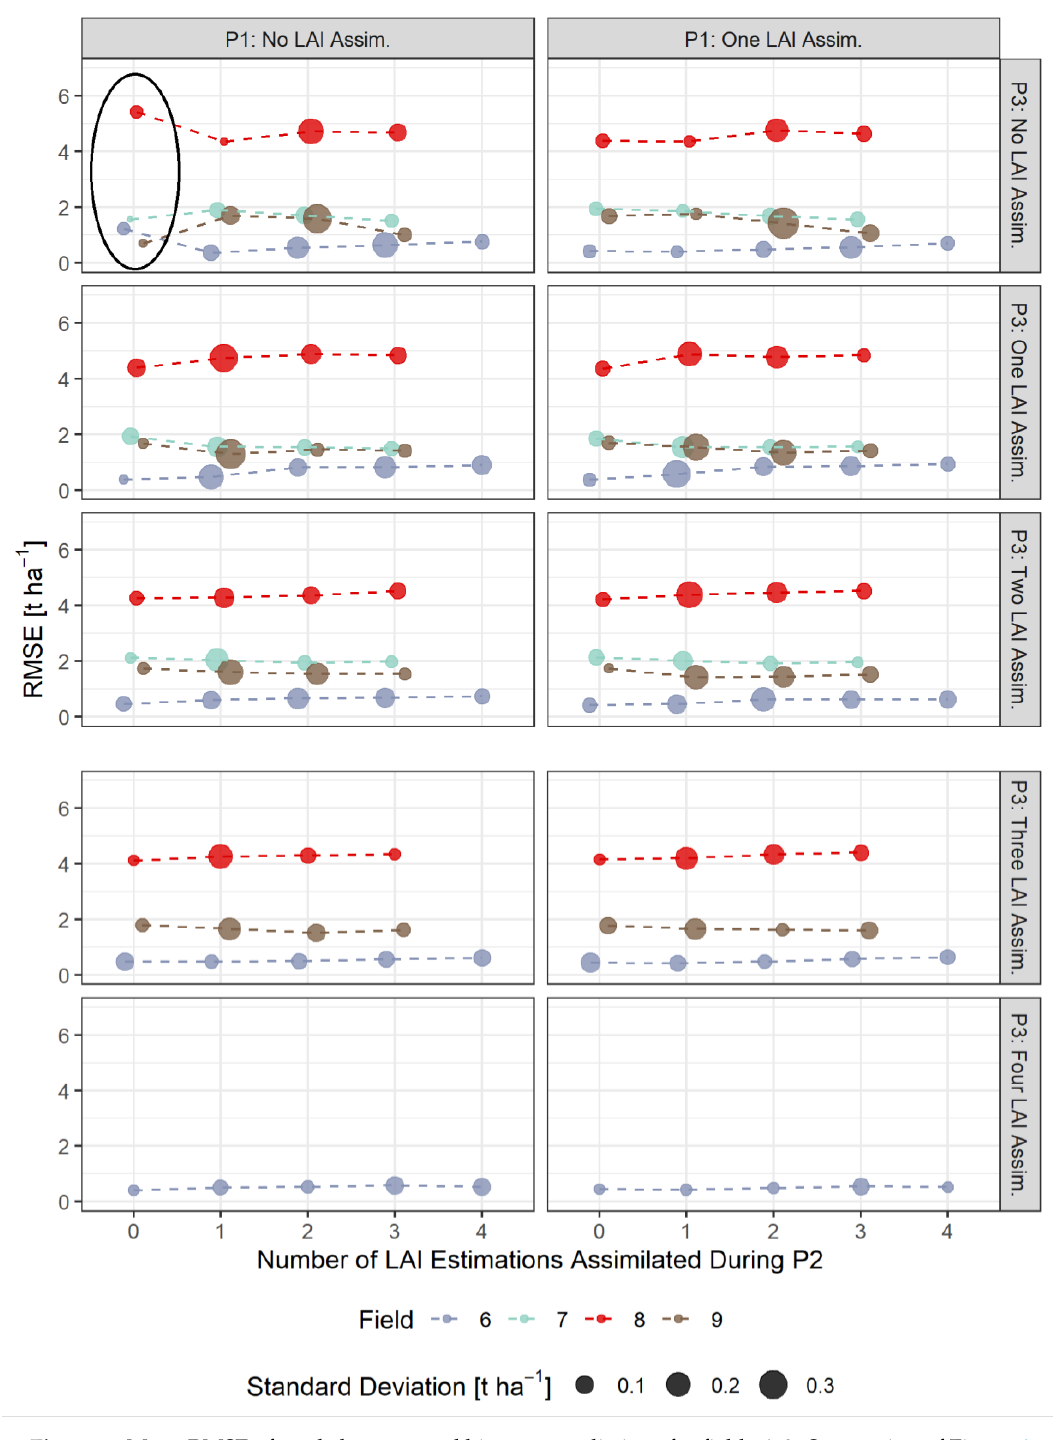
Figure 5. Mean RMSE of total aboveground biomass predictions for fields 6–9. See caption of Figure 4 for further